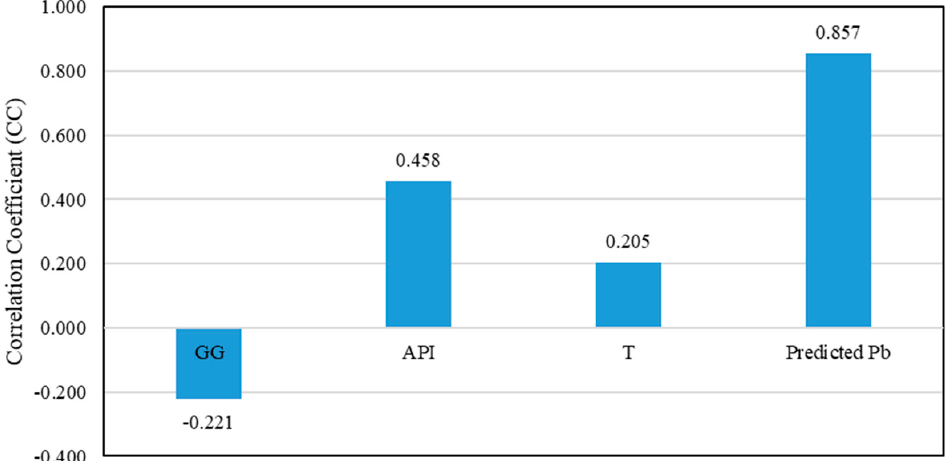
Figure 5. Correlation coefficients of Rs with inputs, including the predicted Pb .